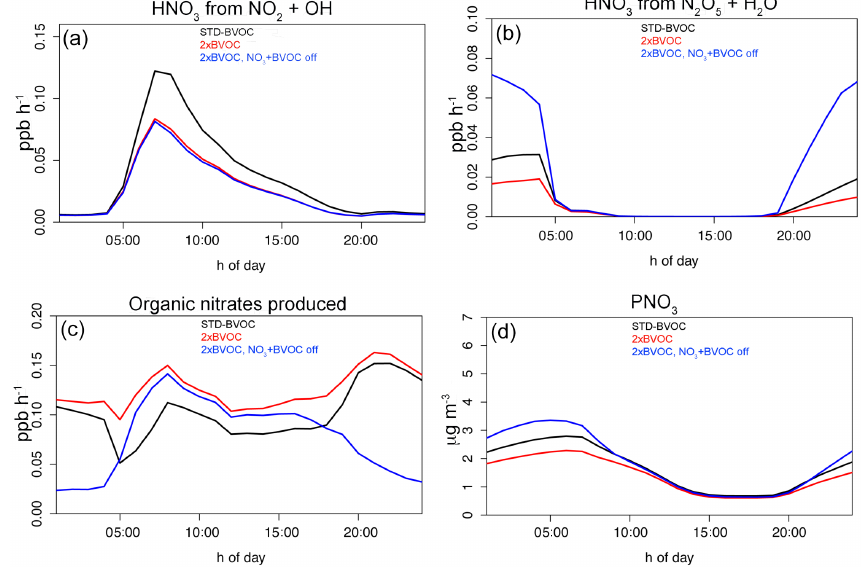
Figure 6. Changes in diurnal cycle of (a) production rate of HNO 3 from daytime reaction, (b) production rate of HNO 3 from nighttime reaction, (c) production rate of organic nitrates and (d) particulate nitrate concentrations. Black: with standard BVOC emissions; red: with doubled BVOC emissions; blue: with doubled BVOC emissions and without BVOC + NO 3 reactions (Payerne, average June 2006).